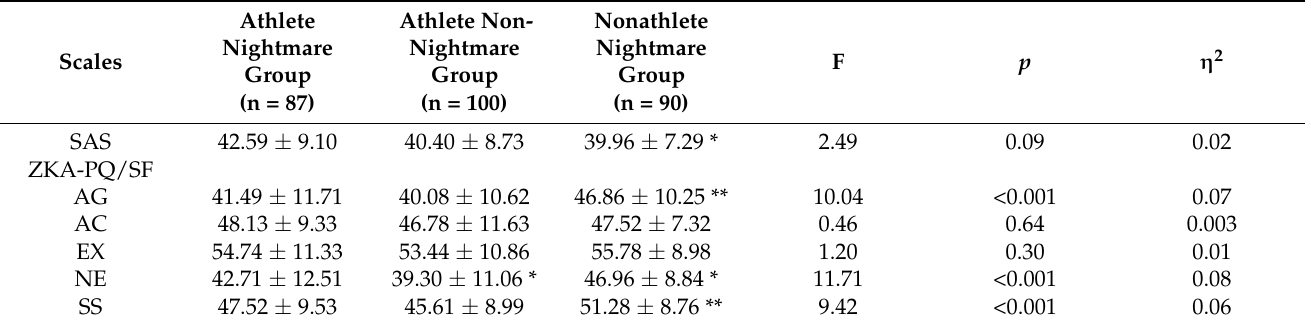
Table 3. Descriptive statistics and differential analysis of participants’ scores on the SAS and ZKA- PQ/SF